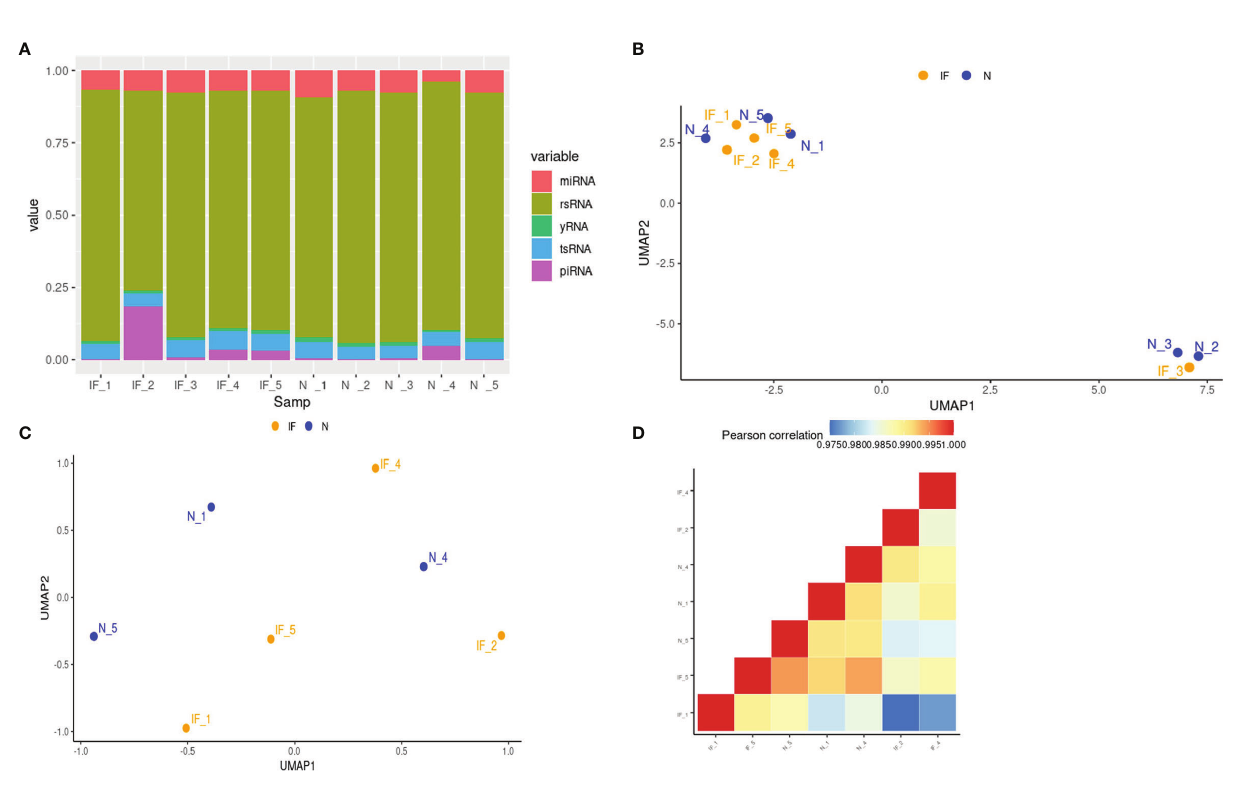
FIGURE 4 | Small RNA pro fi les of CE and the controls. (A) The stacked histogram represented the distribution of small RNA species in each sample. (B) Visualization of 10 samples based on global miRNA expression in a two-dimension space by UMAP. IF represented the in fl amed epididymides, and N indicated the controls. (C) Visualization of 7 samples based on global miRNA expression after removing the corpus and cauda samples in a two-dimension space by UMAP. (D) Global miRNA expression correlation matrix of the 7 caput